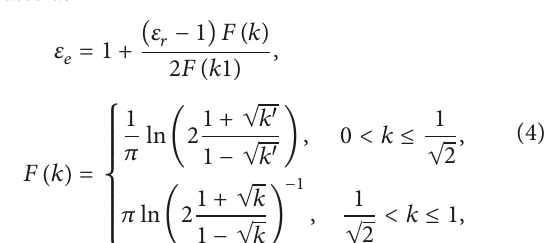
bands with measurements. Liu et al. [13] demonstrated a complex nonlinear dual-band LHM which is geometrically similar to that proposed in [8]. Zhou et al. [14] proposed a double “Z-shaped” structure which exhibits 2 LH passbands under parallel incidence and 3 LH passbands under normal incidence.